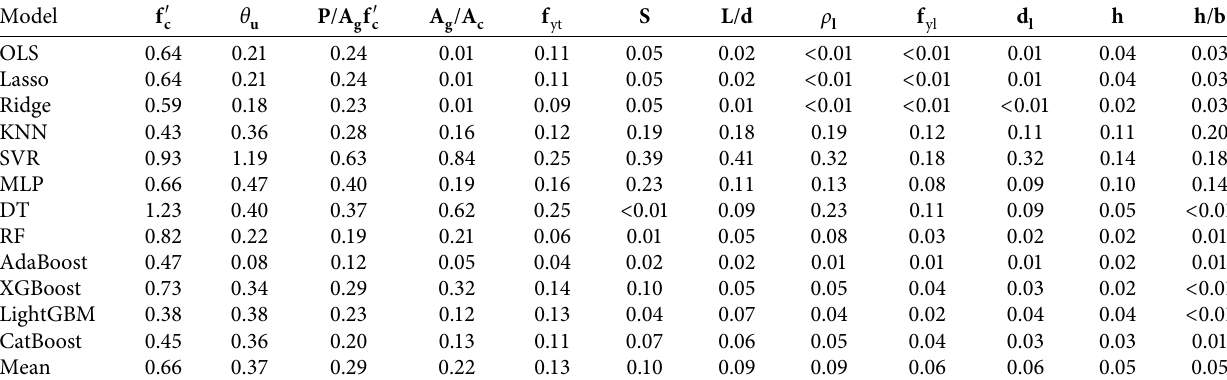
Table 2: Permutation feature importance of 12 features.